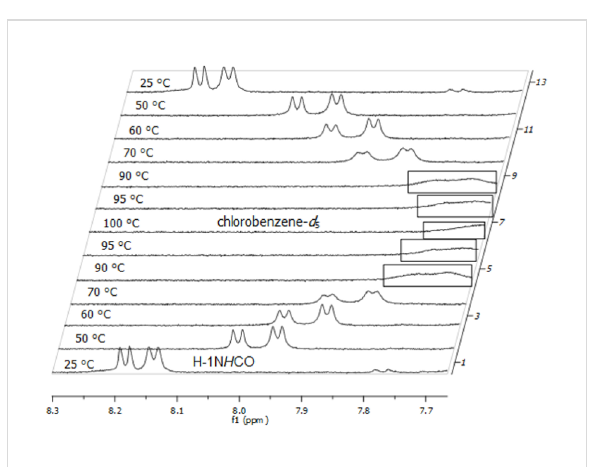
Figure 8: Temperature-dependent 1 H NMR (600 MHz) spectra of building block 1a in DMSO- d 6 .